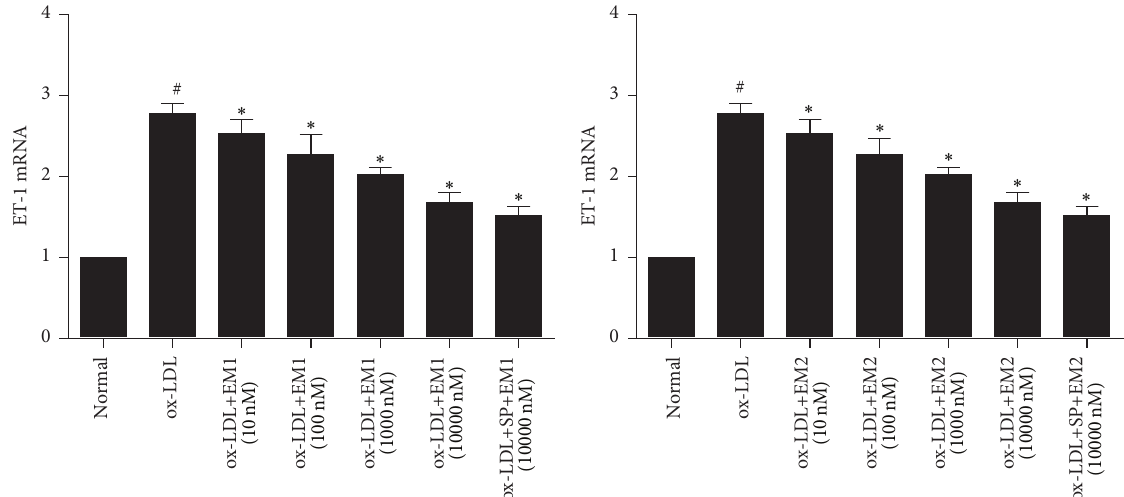
Figure 6: Effects of EM1 and EM2 on ET-1 mRNA expression in HUVECs. RT-PCR shows the effect of EM1 and EM2 on ET-1 mRNA expression in HUVECs in the presence or absence of ox-LDL for 48h. Data is expressed as mean ± SD. ∗ 𝑃 < 0.05 versus control. # 𝑃 < 0.05 versus